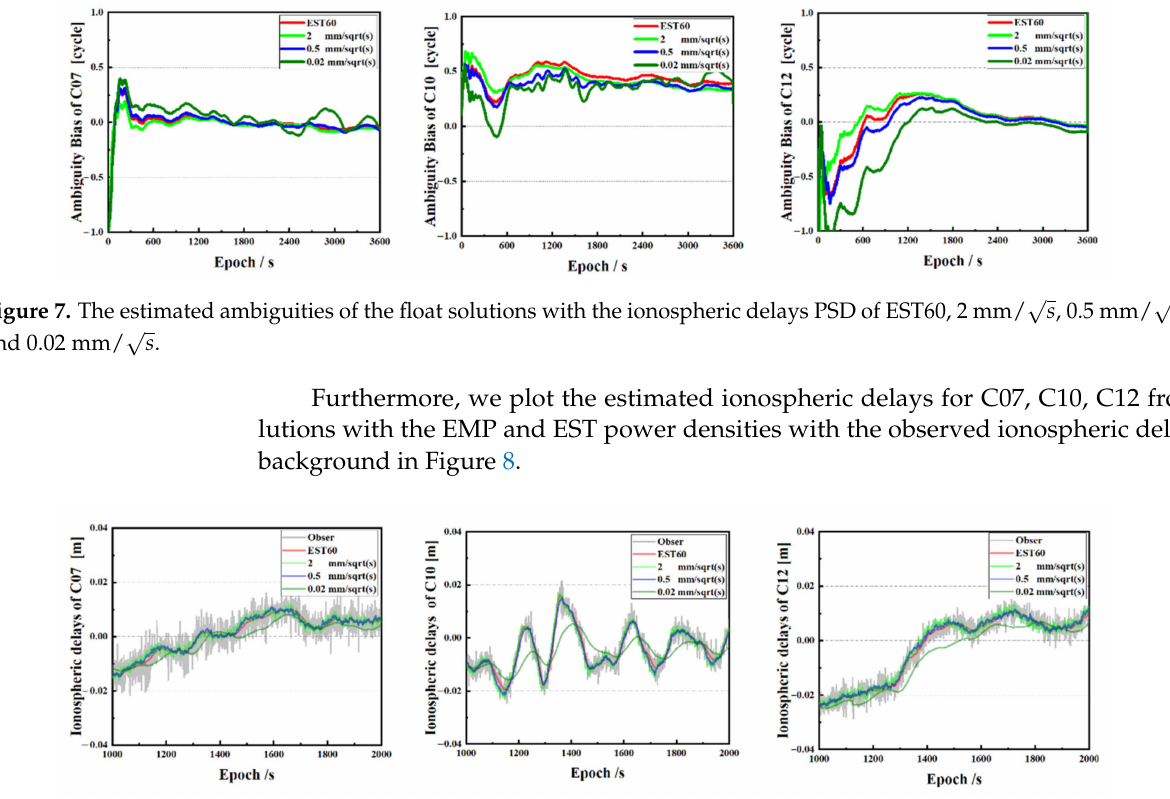
Figure 8. The observed ionospheric delays and the estimated Ionospheric delays of the solutions with EMP and EST60 power densities. Only the estimates with fixed ambiguity are